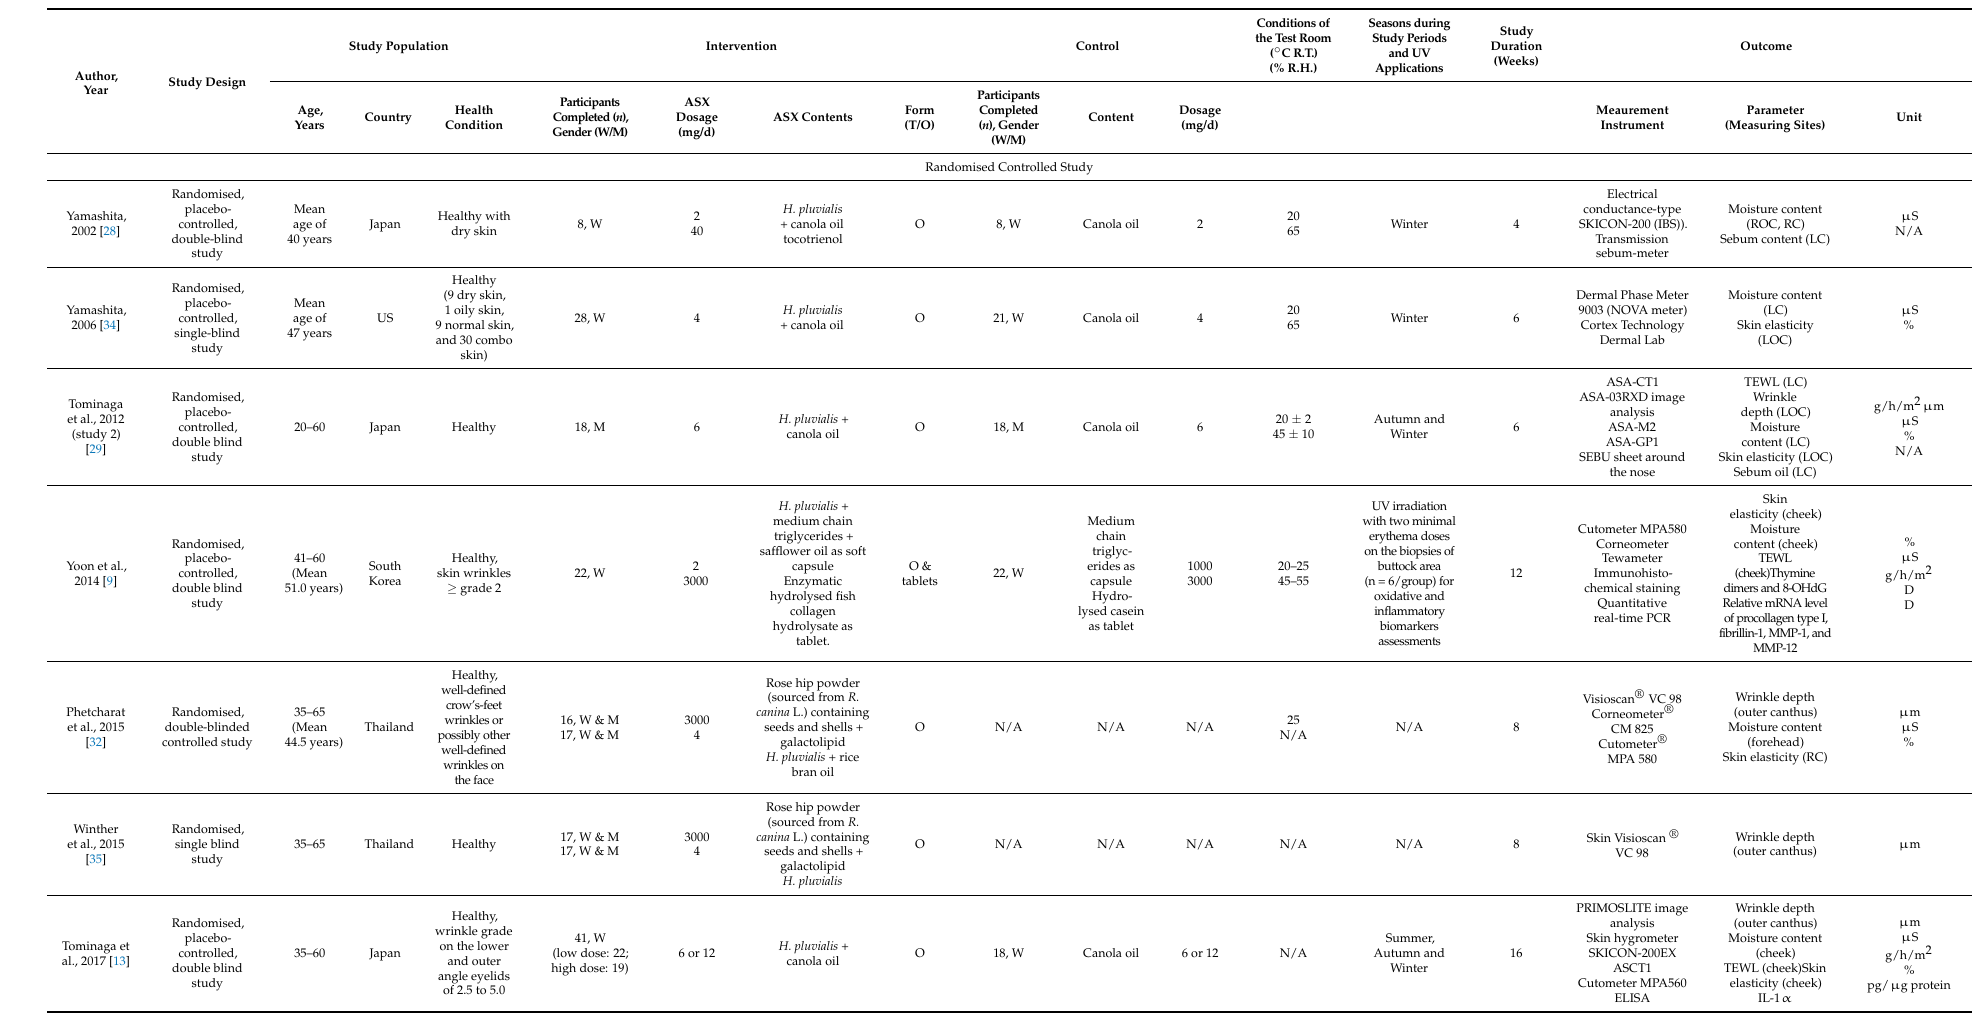
Table 1. Clinical trials investigating the effects of ASX on skin parameters (arranged by publication